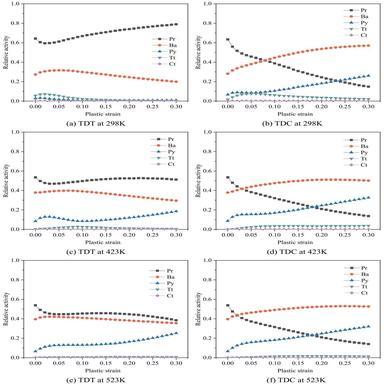
Deformation modes for the TDT and TDC at different temperatures show that the relative activity of Py slip increases with temperature and the activation of twinning is inhibited.